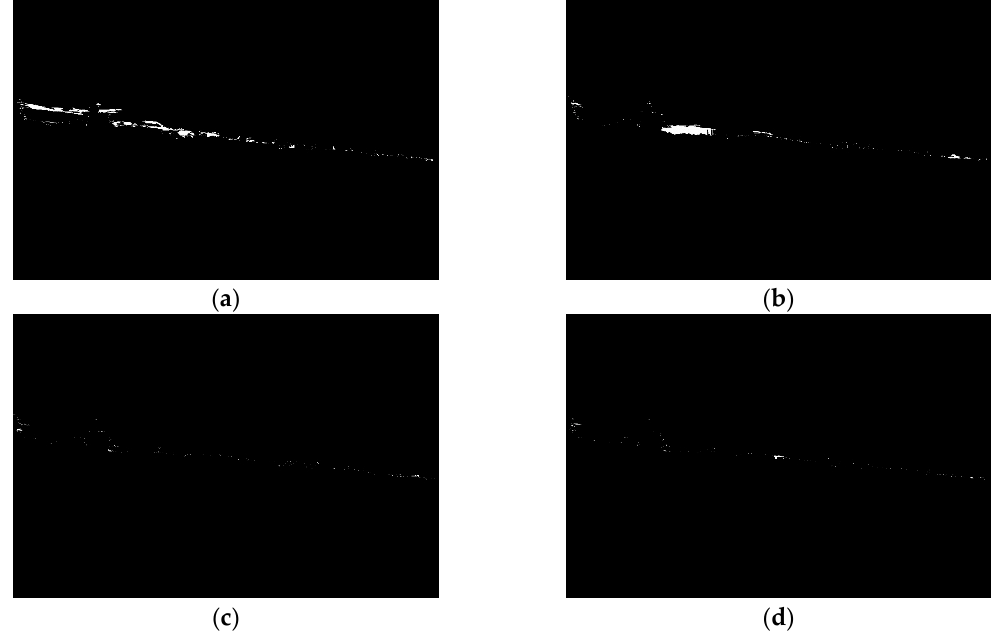
Figure 7. Removed land areas ( a ) at Level 1; ( b ) at Level 2; ( c ) at Level 3; ( d ) at Level 4.